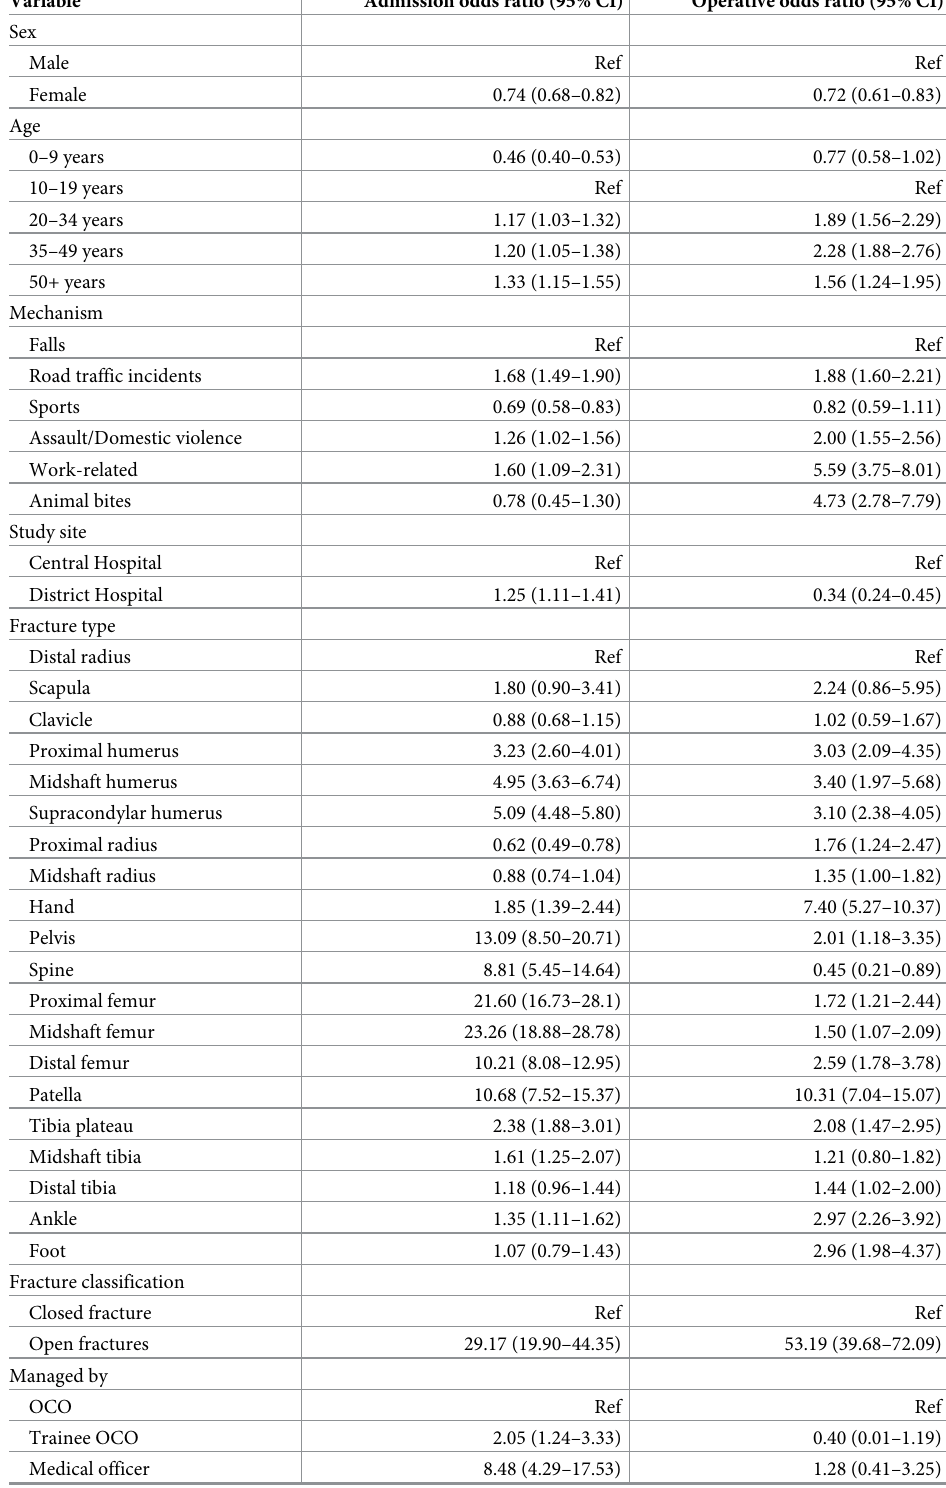
Table 2. Associations with fracture hospital admission and operative